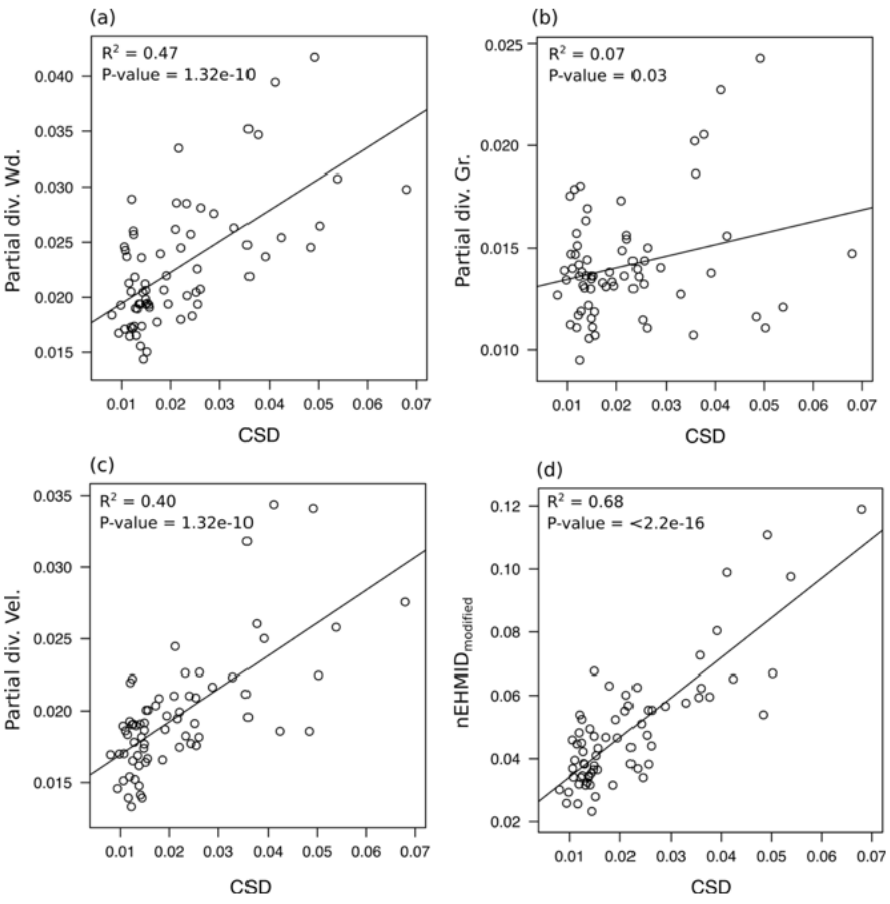
Figure 8. Plots of ( a ) partial diversity of the water depth, ( b ) partial diversity of the bed grain size, ( c ) partial diversity of the flow velocity and ( d ) nEHMIDm according to CSD. R 2 corresponds to the coefficient of determination (square of the Pearson